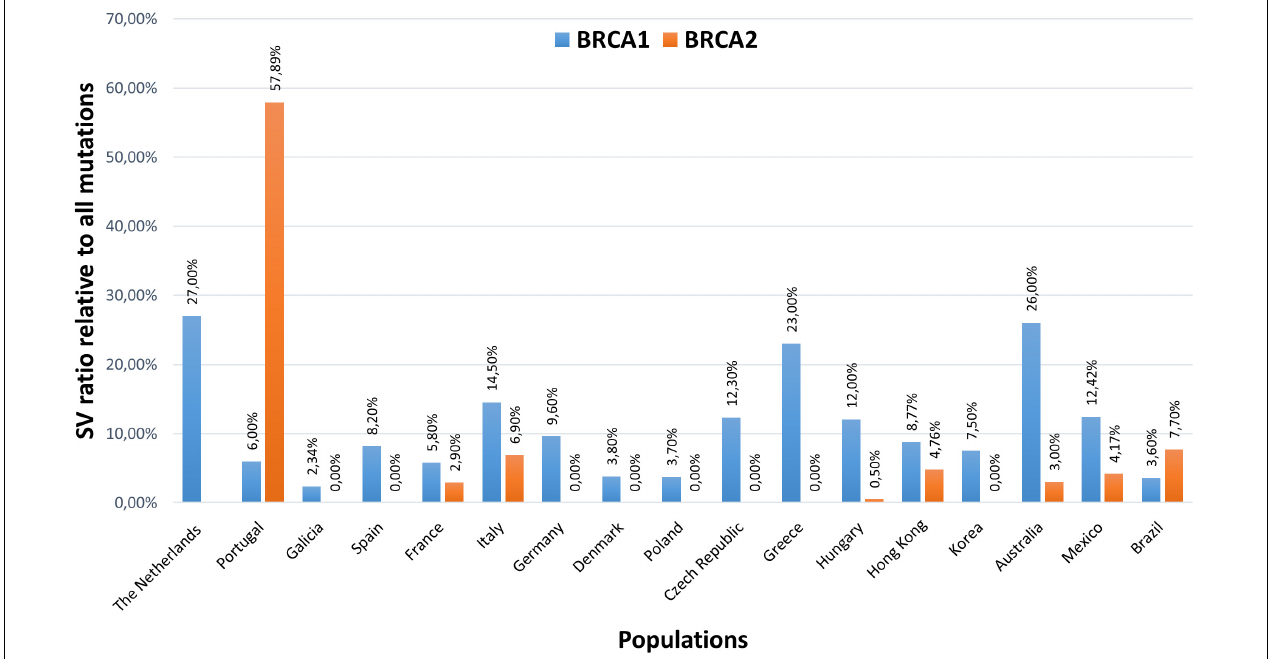
FIGURE 2 | Structural variation ratios of BRCA1 and BRCA2 genes relative to all pathogenic mutations detected in HBOC probands of various ethnicities. The Netherlands (Hogervorst et al., 2003), Portugal (Peixoto et al., 2011), Galicia (Fachal et al., 2014), Spain (de la Hoya et al., 2006), France (Caux-Moncoutier et al., 2011), Italy (Concolino et al., 2018), Germany (Engert et al., 2008), Denmark (Thomassen et al., 2006), Poland (Rudnicka et al., 2013), Czech Republic (Ticha et al., 2010), Greece (Armaou et al., 2009), Hungary (Bozsik et al., 2020), Hong Kong (Kwong et al., 2015), Korea (Seong et al., 2014), Australia (James et al., 2015), Mexico (Lopez-Urrutia et al., 2019), Brazil (Palmero et al.,